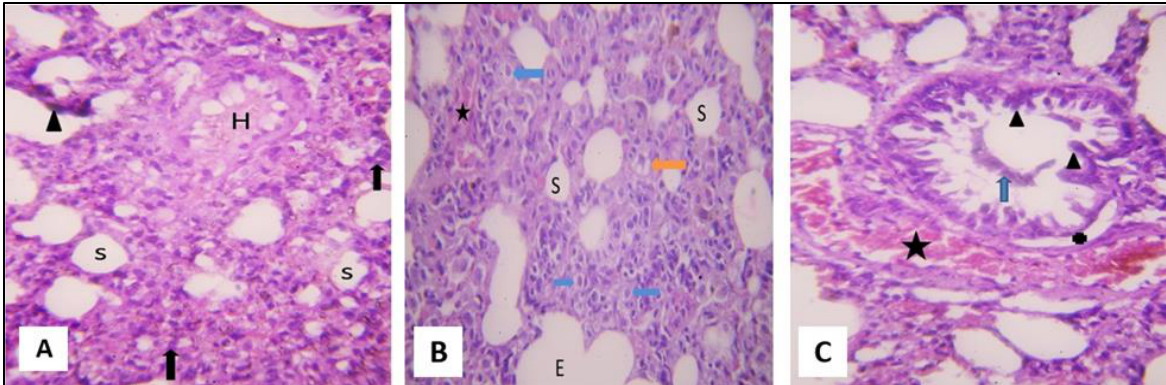
Figure 5. Section of a rat lung of (CP-treated) group II presenting the following features. ( A ) Thick- ened interalveolar septa with heavy mononuclear cellular infiltration ( ↑ ) and marked narrowing of the alveolar spaces (S). Alveolar epithelium is hardly distinguished. One regenerated alveolus lined by rounded type II pneumocytes and filled with homogenous exudate can be distinguished (H). The presence of hemosiderin-laden macrophages ( ▲ ) is noticed (H&E, ×400). ( B ) Thickened interalveo- lar septa with hyperplastic pneumocyte II (blue arrow), foamy macrophage (orange arrow), marked narrowing of the alveolar spaces (S), and over-dilatation of others (E). Congested blood vessel ( ⁕ ) is noticed (H&E, ×400). ( C ) The bronchiole with epithelial cells has strongly stained nuclei ( ▲ ). The bronchiolar lumen is full of exfoliated epithelial cells (blue arrow) and is marked by detachment of bronchiolar epithelium from underlying lamina propria. Congested blood vessels ( ⁕ ) are noticed with extravasated blood cells in the lung interstitium (H&E, ×400). H&E-stained lung sections of (SCRE-treated) group III demonstrated that they were remarkably similar to those of the control, with thin interalveolar septa and clear alveolar cavities. However, some interalveolar septa still contained mononuclear cellular infiltra- tions. The bronchiolar epithelium appeared relatively intact (Figure 6A,B). Figure 6. A rat lung section of group III (SCRE-treated) presenting the following features. ( A ) Thin interalveolar septa with patent alveoli. Pneumocyte type I (I) and type II (II) are noticed. Some al- veoli contained homogeneous exudate (H). Few mononuclear cellular infiltrations ( ↑ ) are noticeable in some interalveolar septa (H&E, ×400). ( B ) A bronchiole shown with relatively intact epithelial lining ( ▲ ). Mononuclear cellular infiltrations (black arrow) are still present with interalveolar septa (H&E, ×400). Examination of the iNOS- and caspase-3 immune-stained cells showed a weakly pos- itive brown cytoplasm reaction in alveolar epithelial lining of the control and group III.